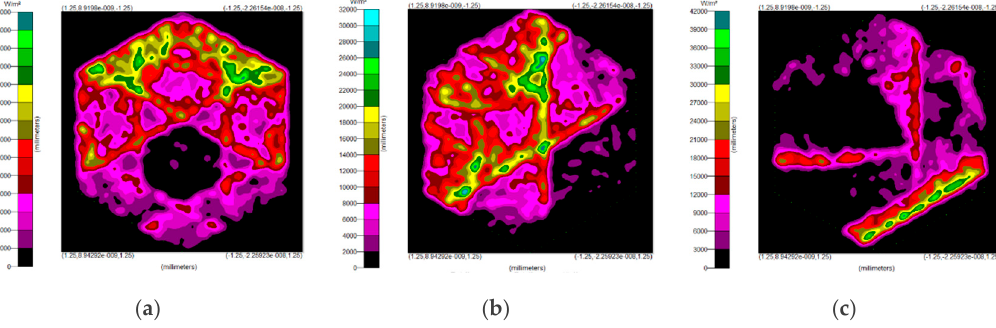
Figure 16. The irradiance distribution of other lateral orientations at ( a ) 0°, ( b ) 15°, and ( c ) 20°.